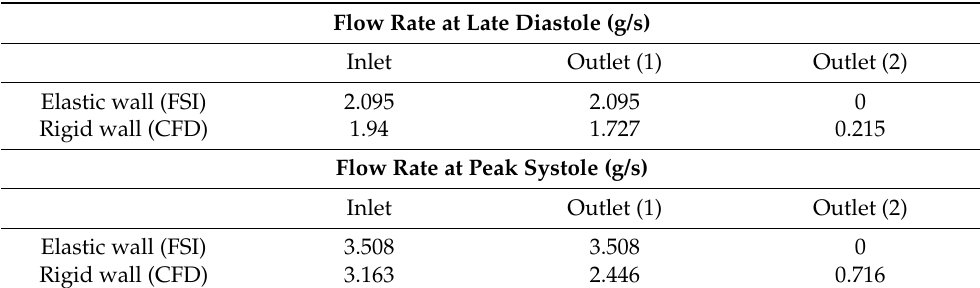
Table 4. RCA (model A) mass flow rate distribution at the late diastole and peak systole of the cardiac cycle for elastic and rigid wall.